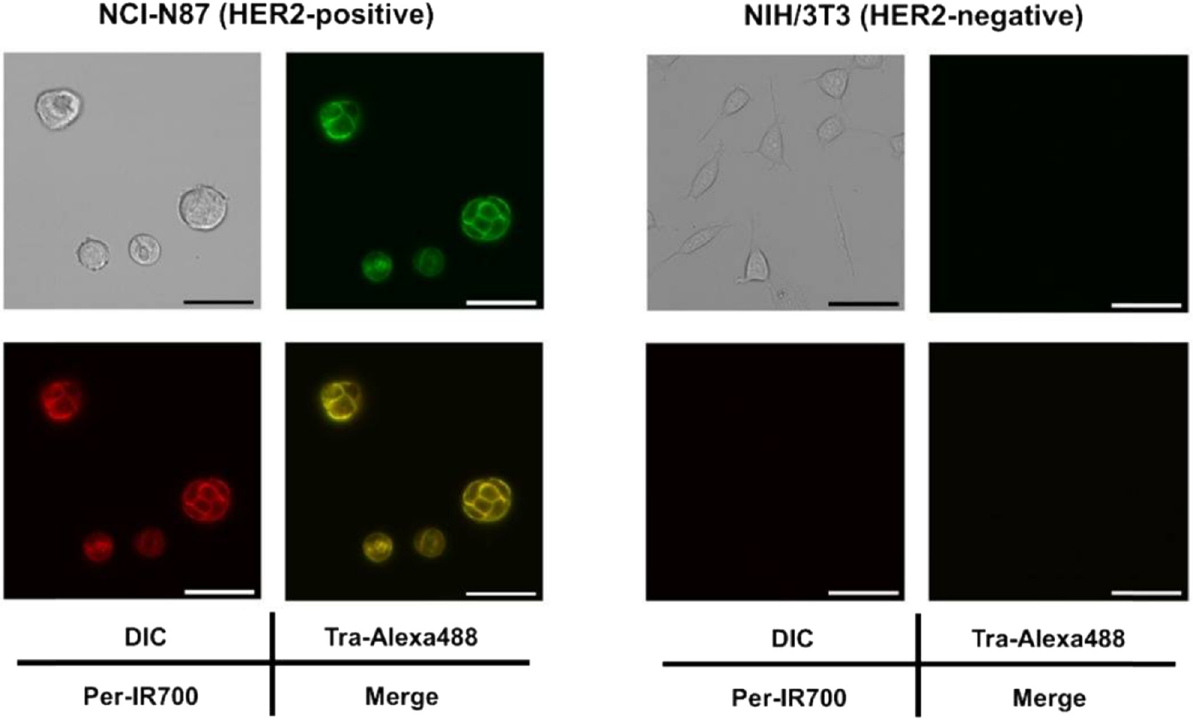
Figure 13: PICs targeting the cell receptor with di ff erent antibodies. Both trastuzumab - Alexa488 ( green ) and pertuzumab - IR700 ( red ) target HER2. After 3 h of incubation, their fl uorescence is localized on the cell surface of the HER2 - positive NCI - N87 cells ( left ) but not in the HER2 - negative NIH/3T3 ( right ) . DIC: di ff erential interference contrast. Scale bar = 50 µm. Figure reproduced under a Creative Commons Attribution 3.0 License from ref. [ 186 ]